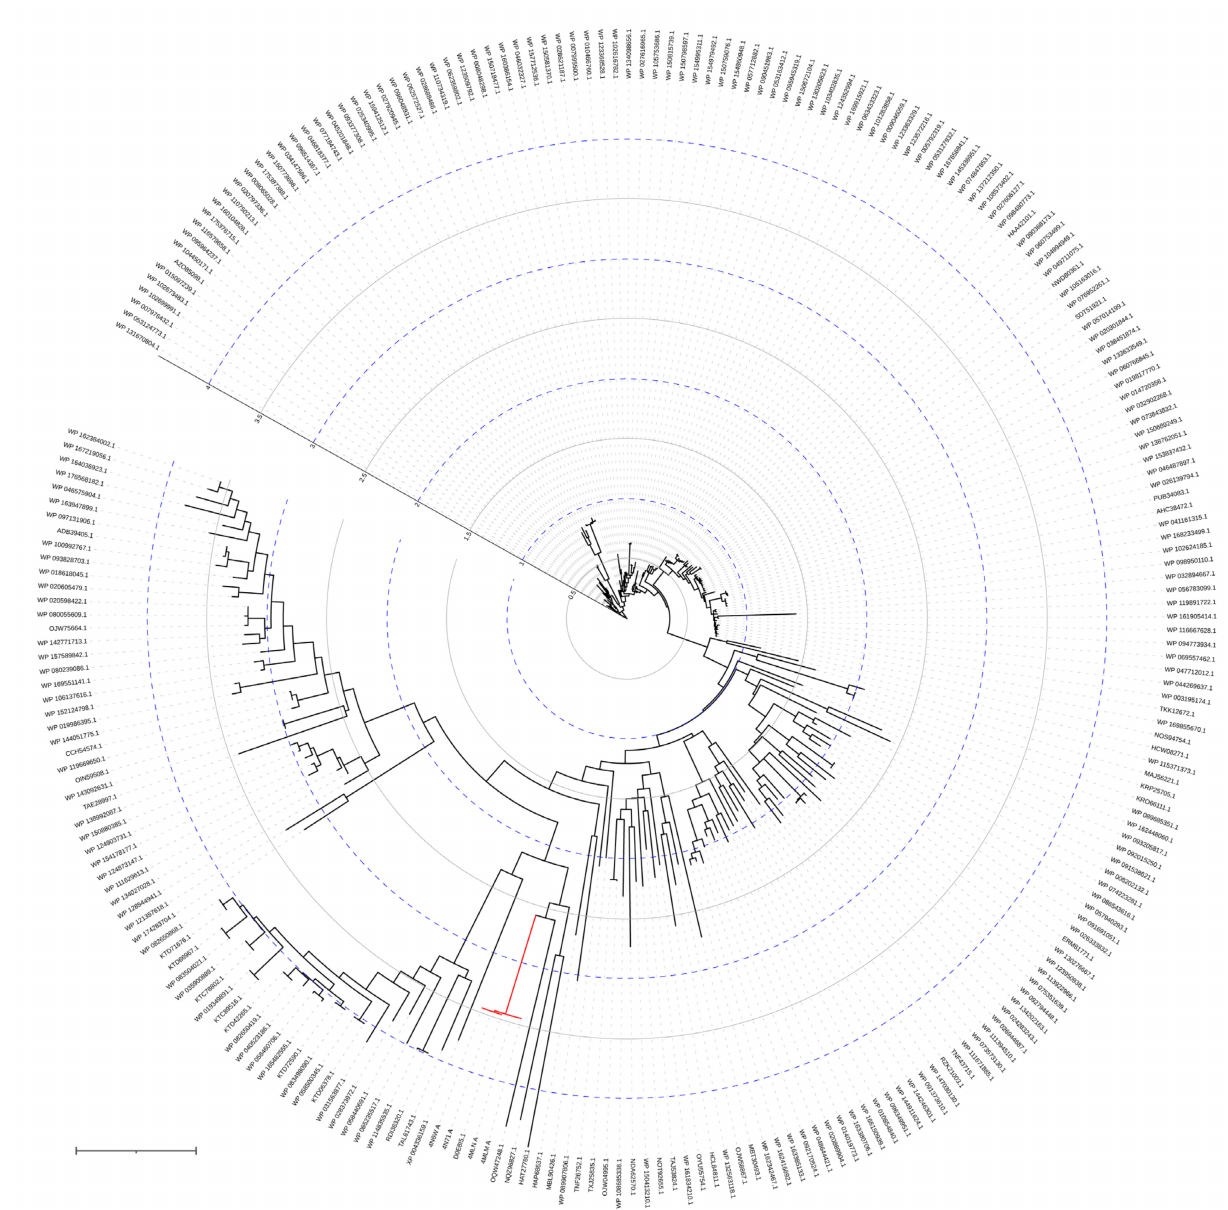
Figure 20. Phylogenetic tree of PhnZ and its homologous enzymes (down to 44% identity). The tree was built as previously with PDB 4MLN as a reference sequence. Enzymes having high (90–100%) identity are highlighted with